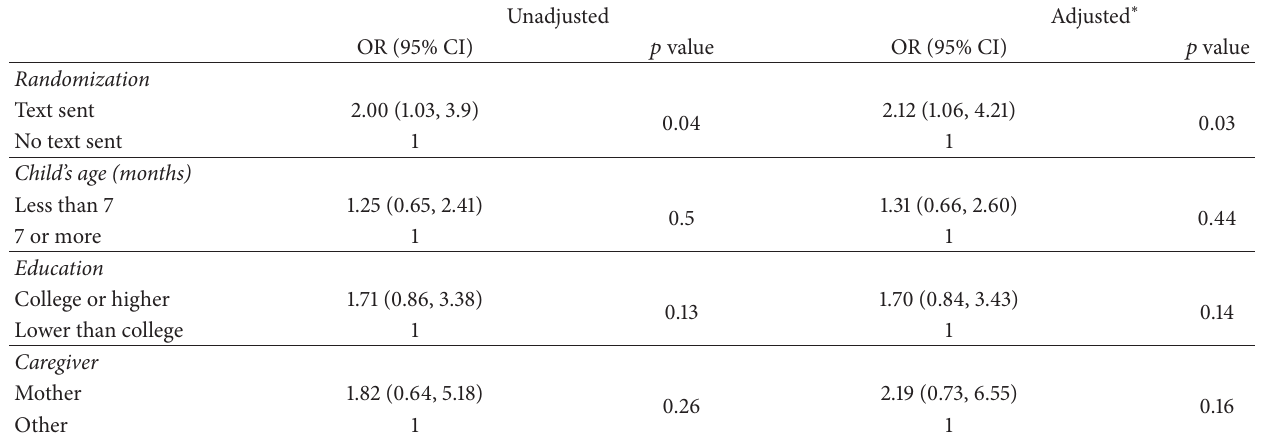
Table 2: Factors associated with reduced no-show